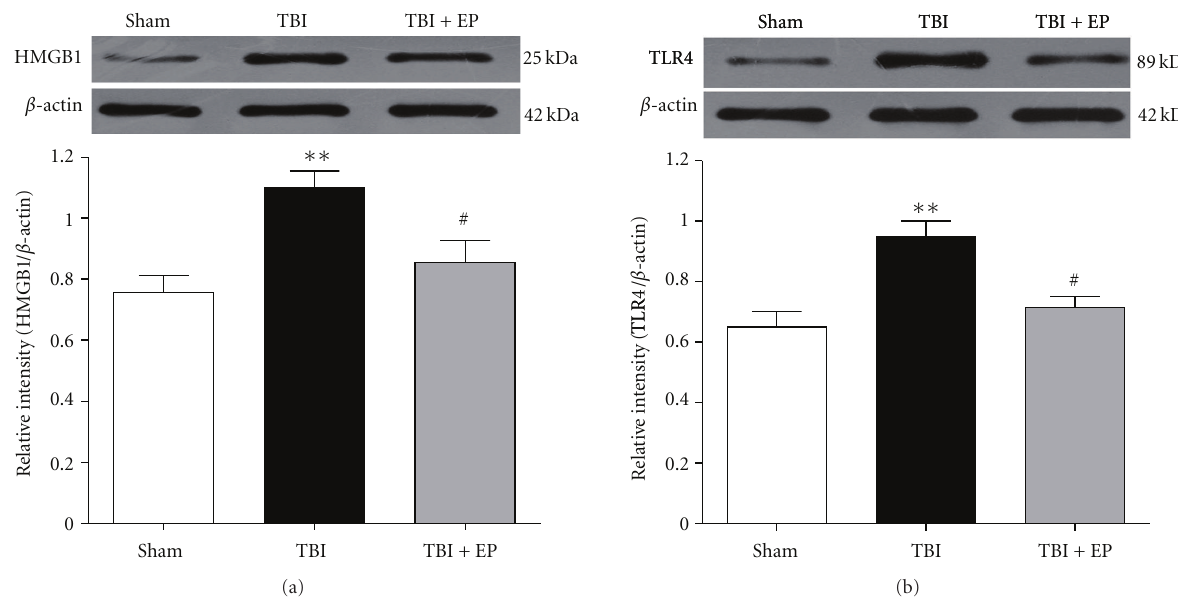
Figure 5: Expression of HMGB1 and TLR4 protein in the rat brain of the Sham group, TBI group, and TBI + EP group. Upper panel represents autoradiogram of the HMGB1 and TLR4 protein expression by Western blot. Bottom panel is quantitative analysis of the Western blot results for the expression of HMGB1 and TLR4 protein. TBI induced a marked increase of HMGB1 and TLR4 protein expression in the brain tissue surrounding the contusion cortex compared to the Sham group ( P < . 01). The HMGB1 and TLR4 protein expressions were significantly downregulated compared to the TBI group after EP treatment ( P < . 05). Bars represent as mean ± SEM; n = 6, each group; ∗∗ P < . 01 versus Sham group, # P < . 05 versus TBI